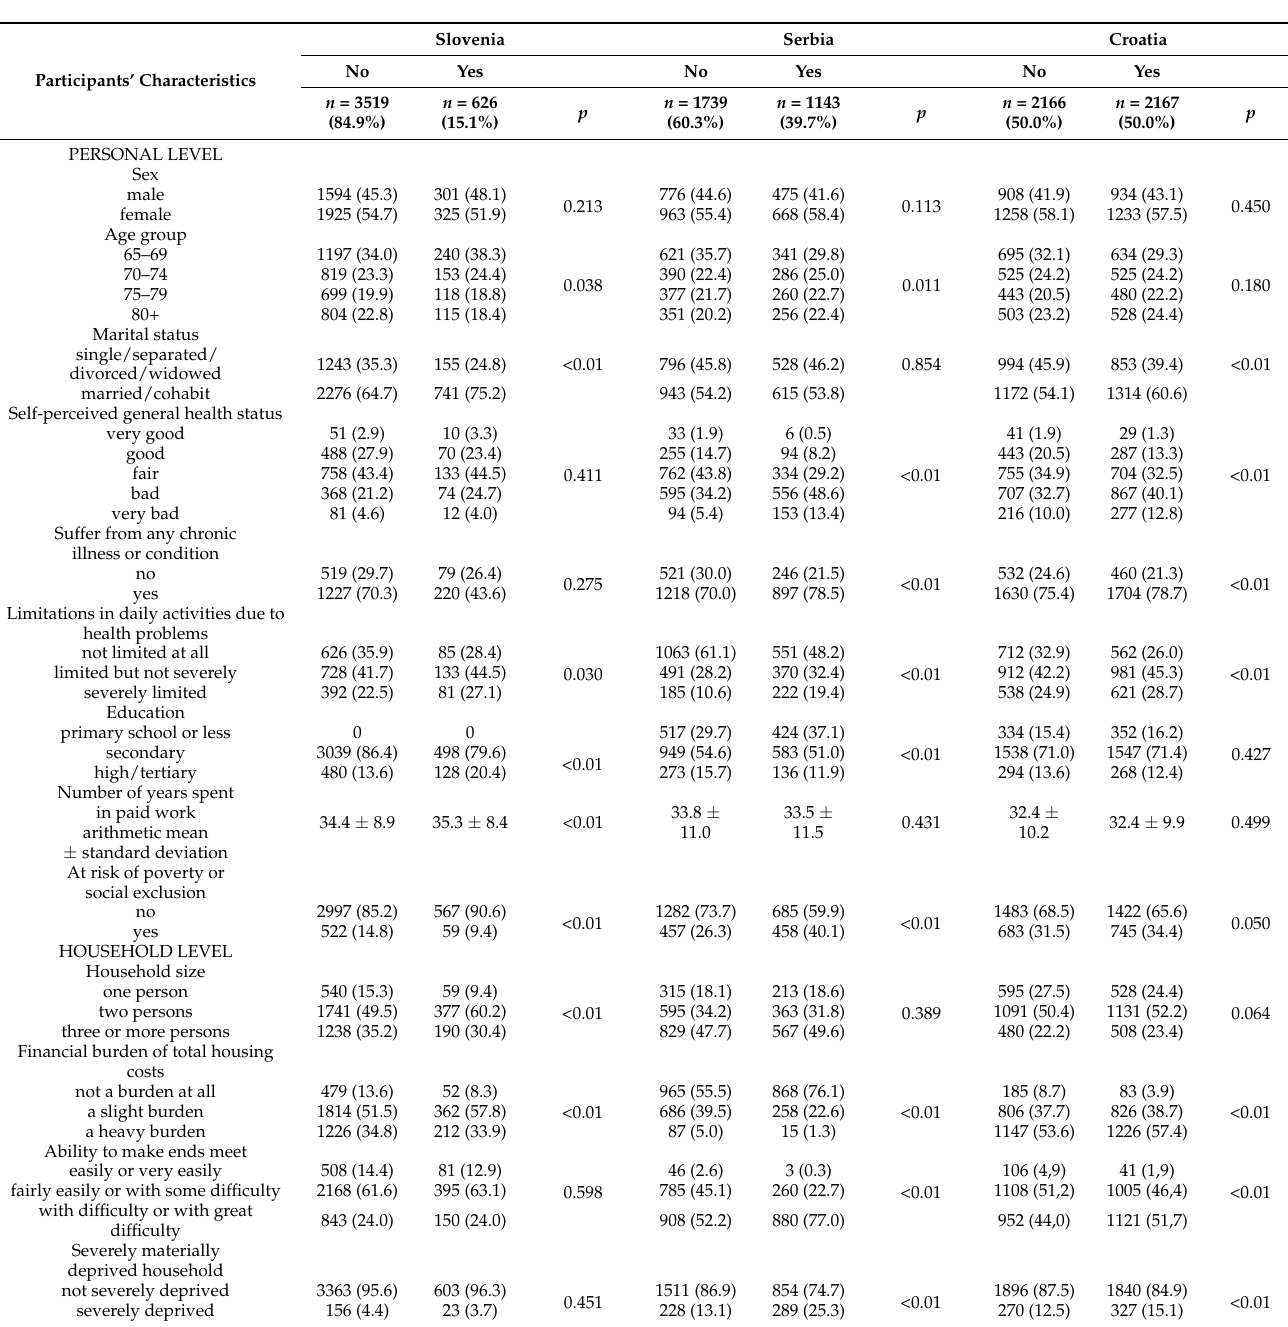
Table 3. Distribution of participants with and without the financial burden of medical care in Slovenia, Serbia, and Croatia. Slovenia Serbia